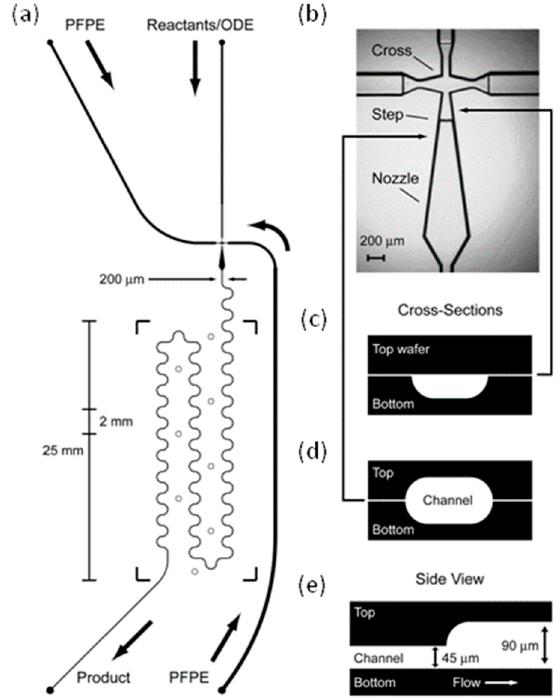
Figure 4. The microreactor channel design with droplet jet injector used by Chan et al. [87]: ( a ) Channel schematic showing dimensions, inlets ( ● ), thermocouple wells ( ○ ), and boundaries of Kapton heater [87] ( b ) Optical micrograph of droplet injection cross. ODE is injected into the top channel, while the PFPE is injected in the side channels ( c ) Lateral “D”-shaped cross section of channel etched on the bottom wafer only ( d ) Cross-section of ellipsoidal channel etched on both top and bottom wafers. ( e ) Axial cross-section showing the 45 μ m stepped up in channel height. Reproduced with permission from Chan, E.M., et al., Journal of the American Chemical Society ; published by American Chemical Society, 2005.